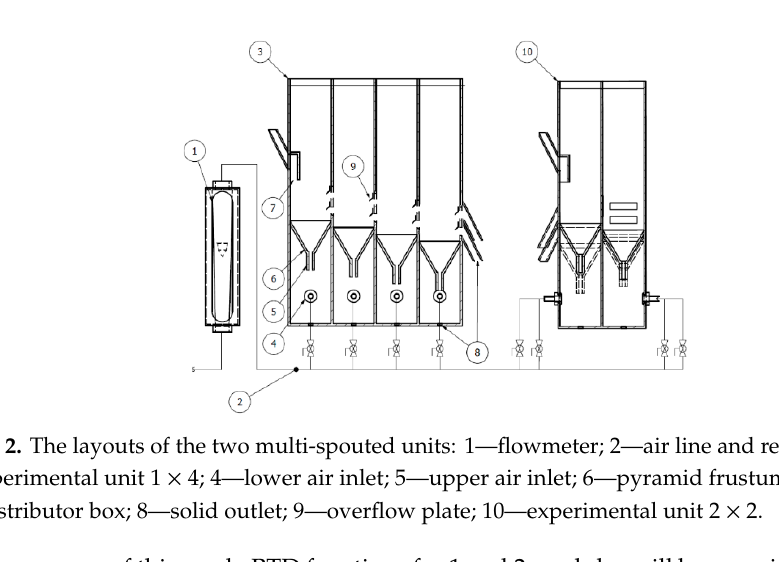
Figure 2. The layouts of the two multi-spouted units: 1—flowmeter; 2—air line and regulation valves; 3—experimental unit 1 × 4; 4—lower air inlet; 5—upper air inlet; 6—pyramid frustum; 7—solid inlet and distributor box; 8—solid outlet; 9—overflow plate; 10—experimental unit 2 × 2.